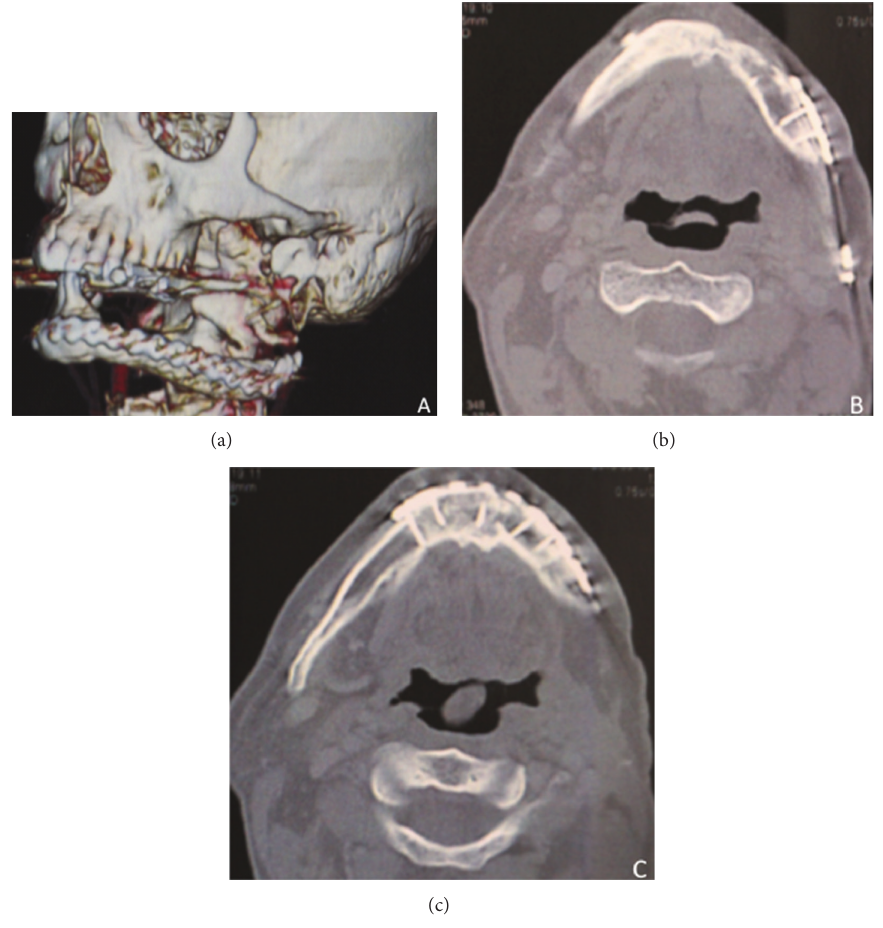
Figure 4: Computed tomography (CT) performed after 8 years of followup. (a) Three-dimensional reconstruction illustrates the osseous consolidation between the mandible and the fibula. (b-c) Axial slices CT showing no evidence of local